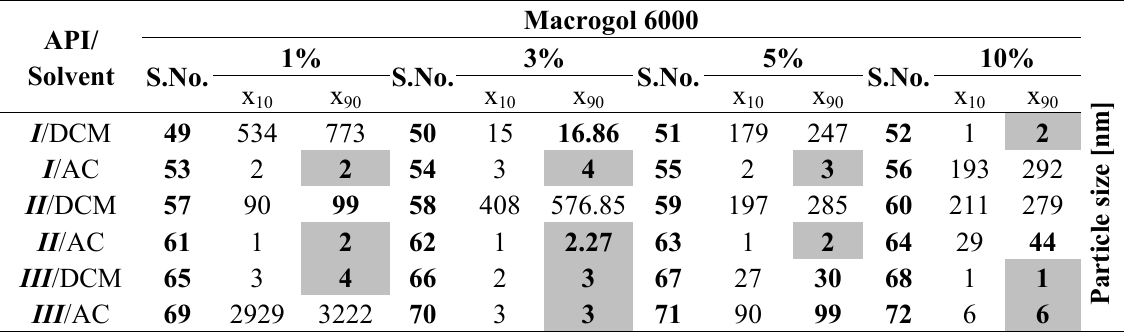
Table 3. Particle size (x , x [nm]) of APIs I – III and concentration [%] of macrogol 10 90 6000 in dichloromethane (DCM) or acetone (AC). All the presented results are reported as medium value of four independent measurements, repeatability was up to 6%. Samples that contained nanoparticles <200 nm are bolded; nanoparticles <10 nm are indicated by grey background. (S.No. = sample